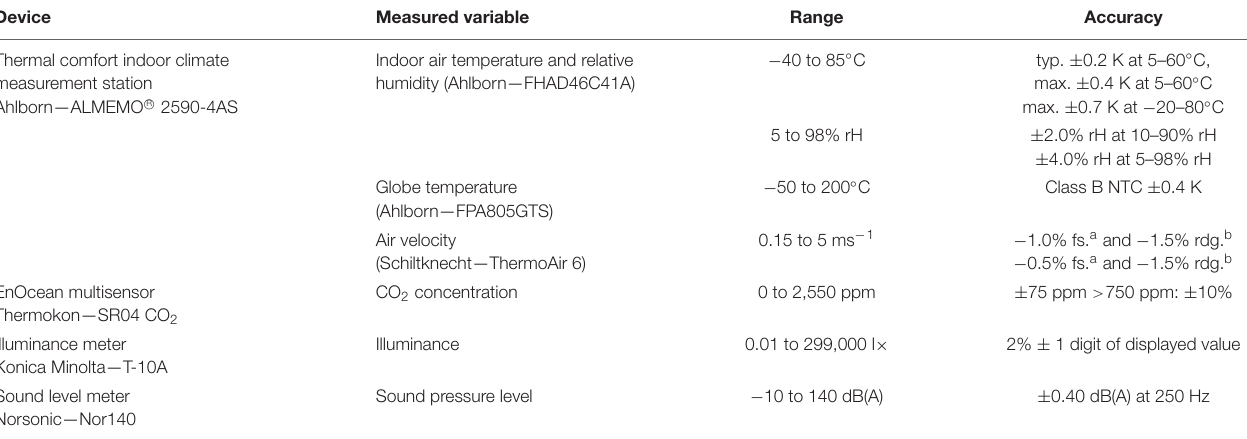
TABLE 2 | Measurement devices of the used monitoring infrastructure. Device Measured variable Range Accuracy